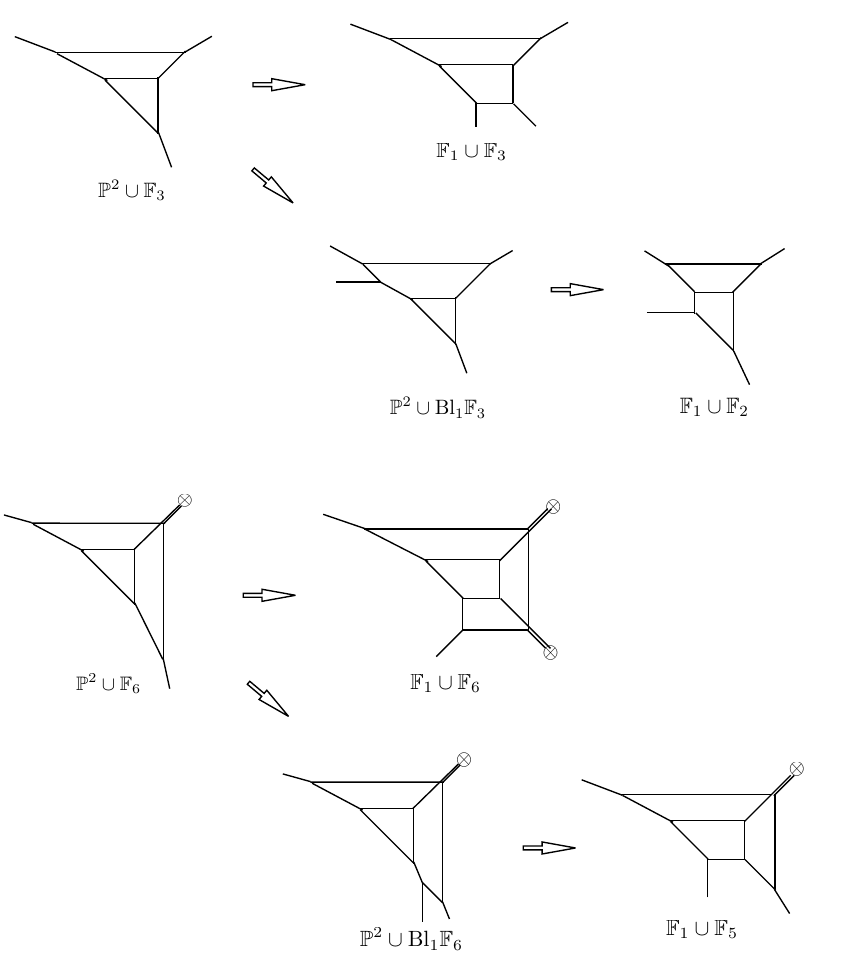
Figure 9. Geometric transitions from P 2